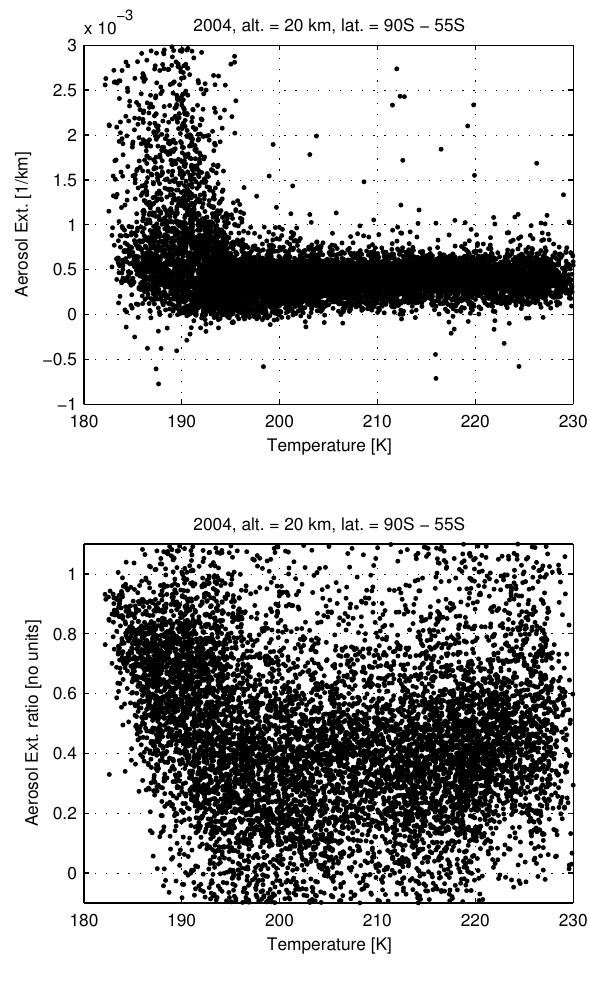
Fig. 9. GOMOS measurements of Polar Stratospheric Clouds. Top panel: optical extinction at 500 nm versus temperature at an altitude of 20 km, for all dark limb occultations in 2004 at latitudes below 55 ◦ S. Bottom panel: extinction ratio (600/400 nm), derived from the same measurements.